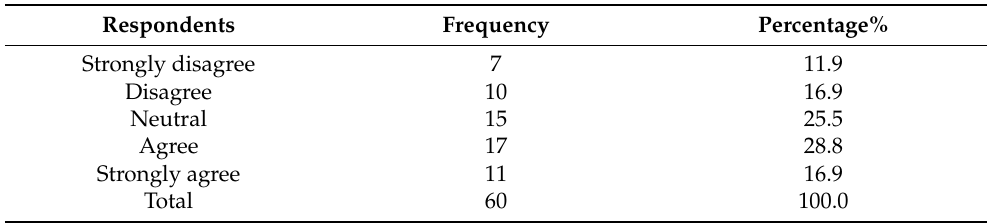
Table 10. The employment of committees effectively improves the quality and efficiency of the board’s tasks and